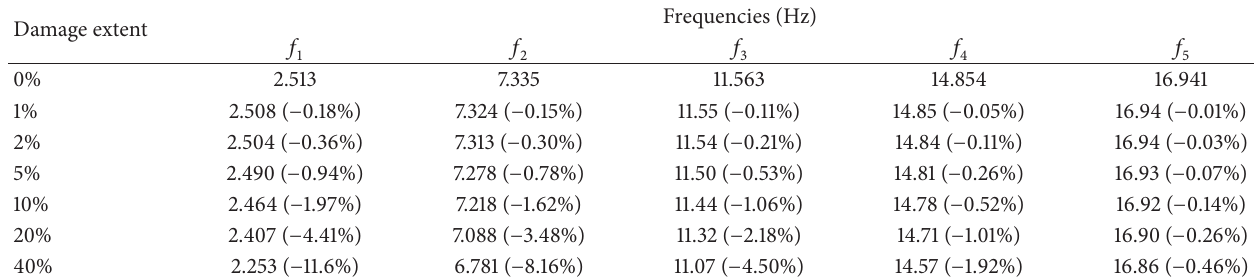
Table 1: Natural frequency before and after sudden